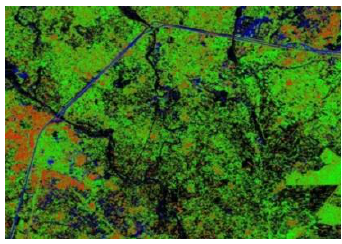
Fig. 8 Parallelepiped classified PALSAR data